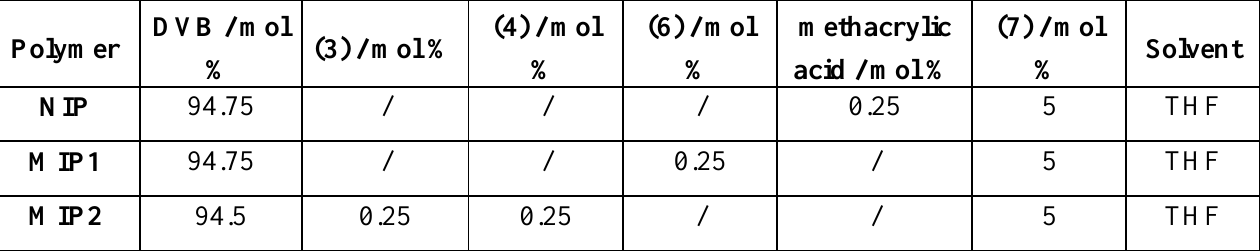
Table 1. Experimental details of polymers syntheses (see